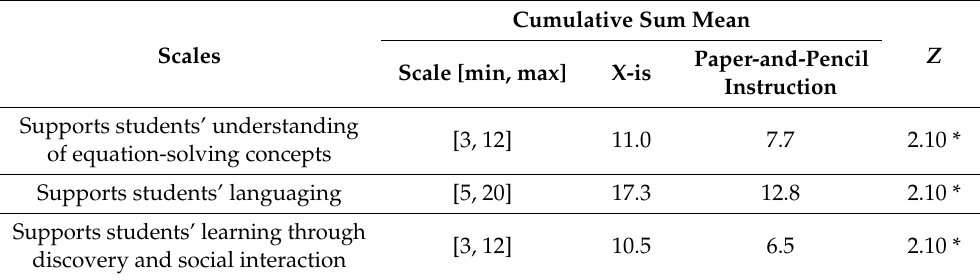
Table 4. Teachers’ ratings of the learning support of X-is compared to paper-and-pencil instruction.